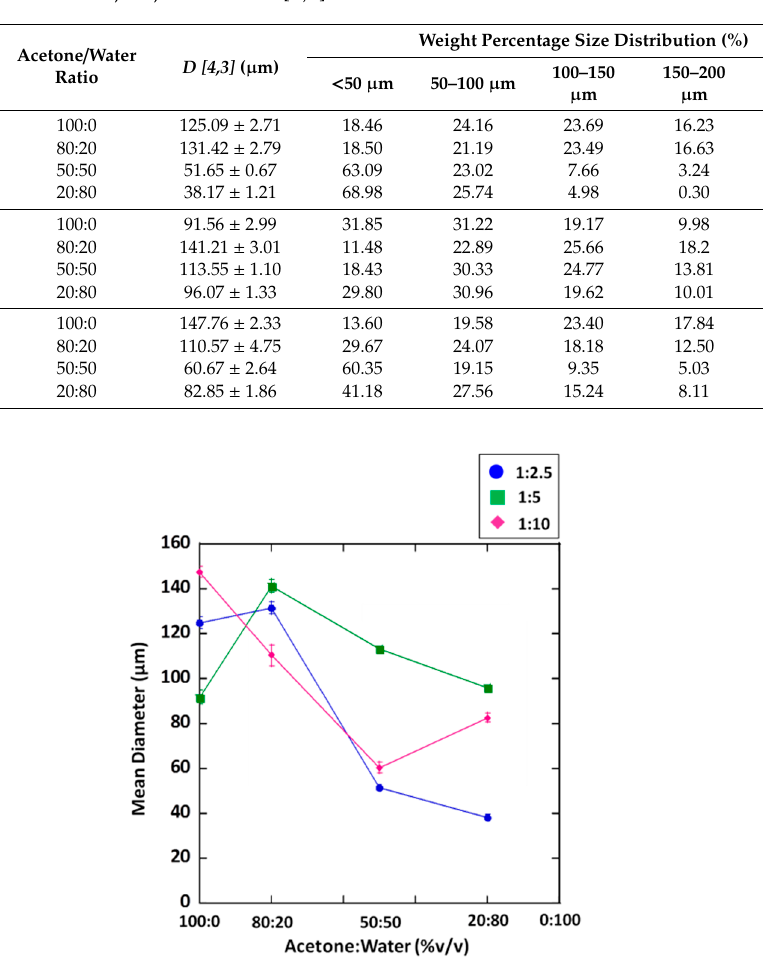
Figure 2. Mean diameters of cenospheres collected from using different ratios of freshly prepared acetone–water mixtures, a 4-h soaking period, and fly ash / medium ratios of 1:2.5, 1:5, and